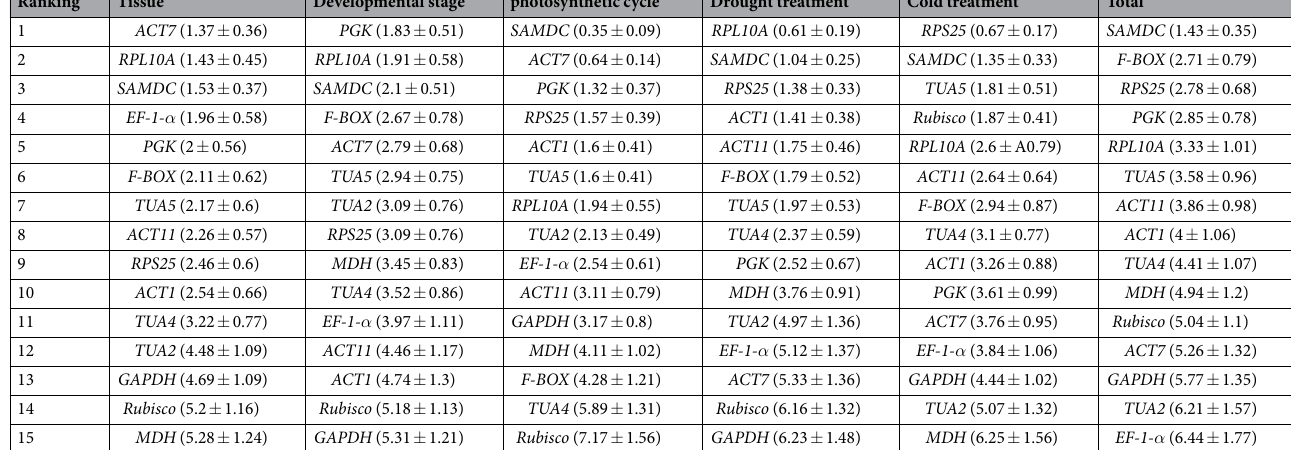
Table 1. Expression stability values for Neolamarckia cadamba candidate reference genes calculated by BestKeeper. Note: Fifteen candidate reference genes are evaluated by the lowest values of the coefficient of variance (CV) and standard deviation (SD). The number in the bracket indicated that CV ± SD.